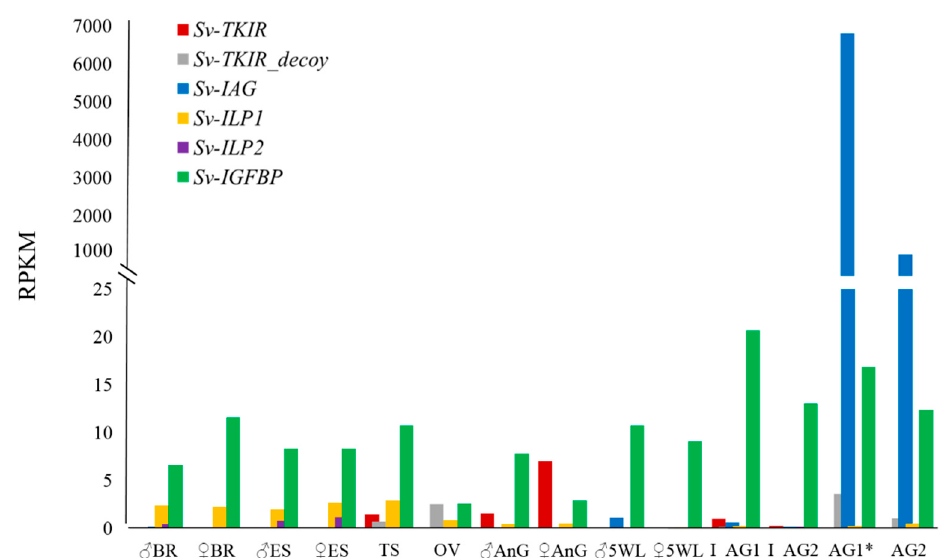
Figure 3. Spatial expression profile summarising all insulin factors identified in Sagmariasus verreauxi for a cohesive depiction of our current understanding of the insulin endocrine system: IAG [38]; ILP1 and IGFBP [7]; the active (TKIR) and decoy (TKIR_decoy) tyrosine kinase insulin receptors [34,39]; and Sv-ILP2. Quantified as RPKM; tissue abbreviations as previously described.